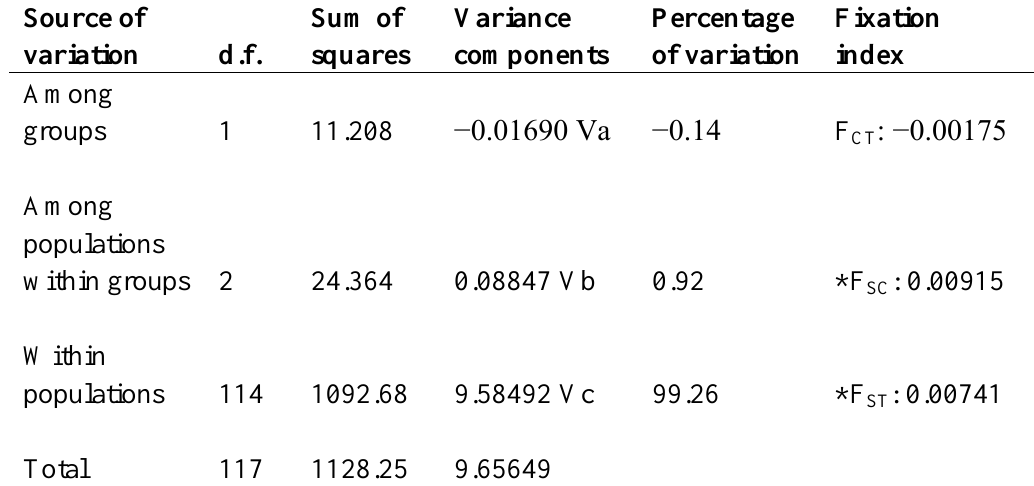
Table 2. Analyses of Molecular Variance (AMOVA) showing the hierarchical genetic partitioning in FIV from single and dual